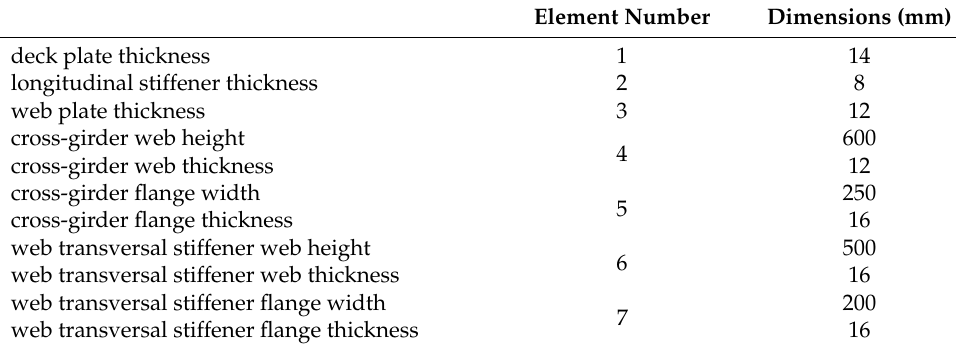
Figure 5. The modelled detail, marked with each structural element for identification, the loading conditions, and location of the evaluation path in the model. Table 1. Dimensions of the model